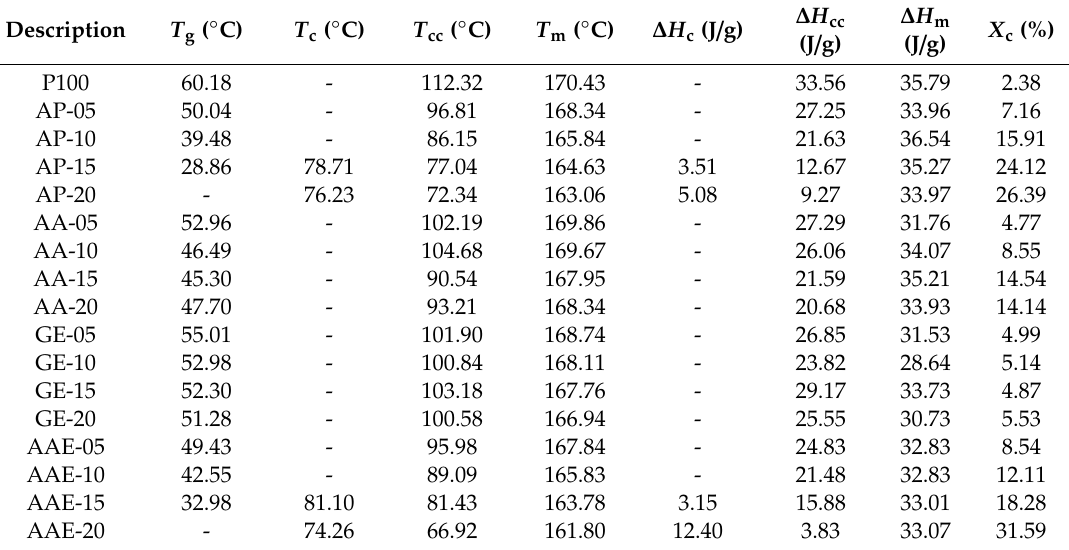
Figure 2. Differential scanning calorimetry (DSC) curves for neat PLA and PLA plasticized with varying plasticizer types and 20 phr. Table 4. DSC data for neat PLA and PLA plasticized with varying plasticizer types and contents.